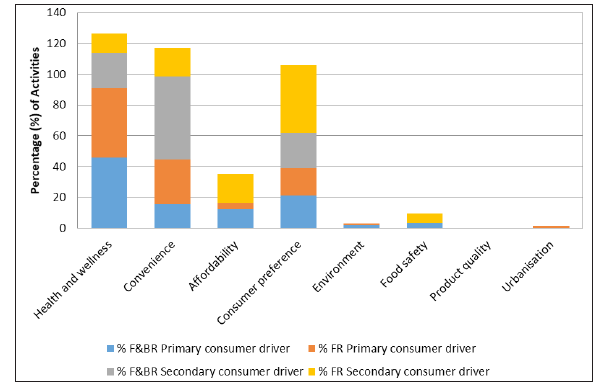
Figure 8: Primary and secondary consumer drivers for innovation from Food & Beverage Reporter (F&BR) and South African Food Review (FR)